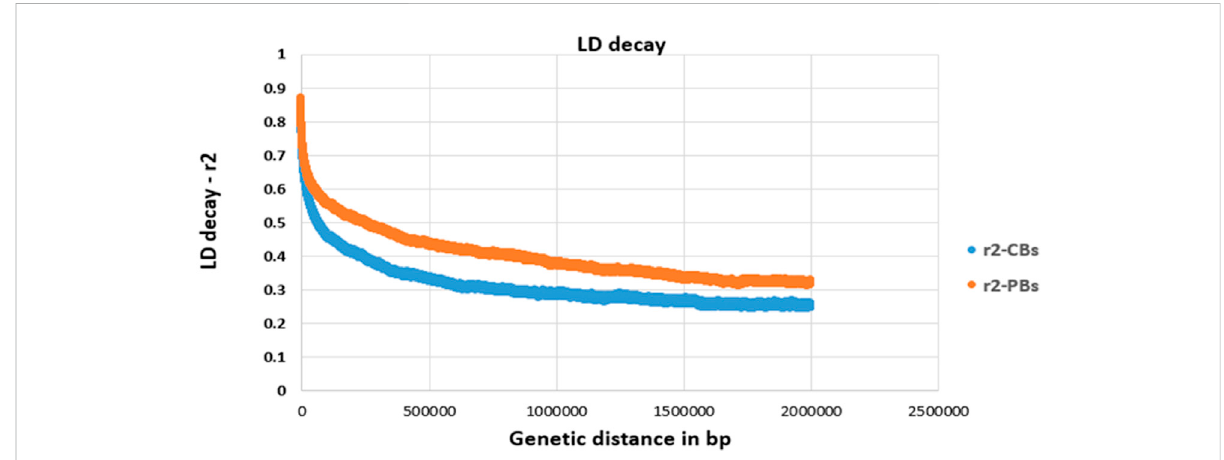
FIGURE 1 Linkagedisequilibrium(LD, r 2 )decayforSSC1ofCBsandPBsasafunctionofinter-SNPdistance.Physical(genetic)distanceismeasuredinbase pair